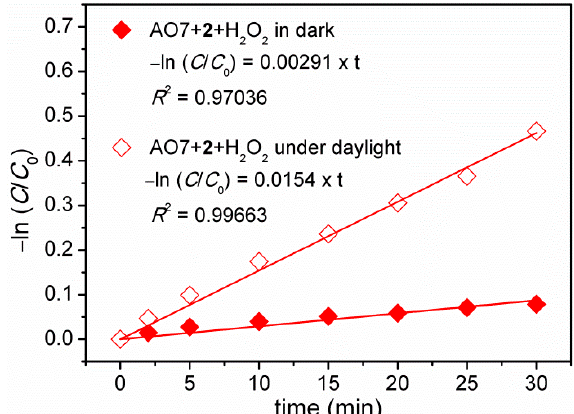
Figure 6. Plots of first-order kinetics model for AO7 degradation by 2 / H 2 O 2 in dark conditions and under daylight.